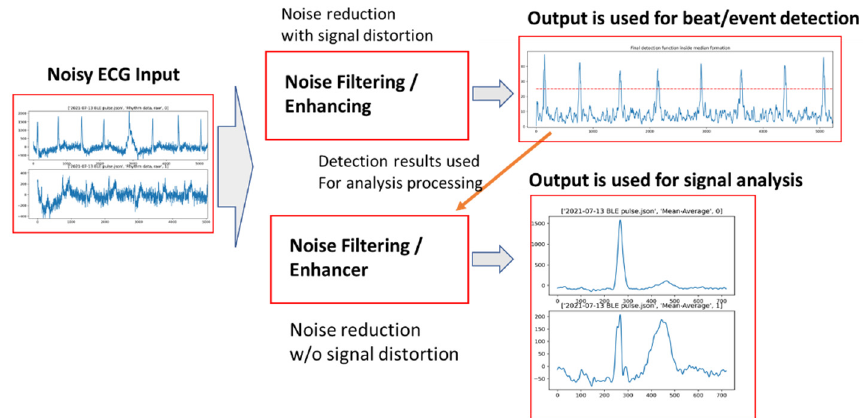
Figure 4. Signal preprocessing can have 2 parallel paths, one (the upper path) is mainly for noise reduction and SNR improvement, but with some signal distortion, while the other (the bottom path) is also for noise reduction but with minimal signal distortion. The results from the first path can be used to assist the second path, e.g., signal averaging; as shown in the figure, an average beat is formed with the trigger points detected from the first path.